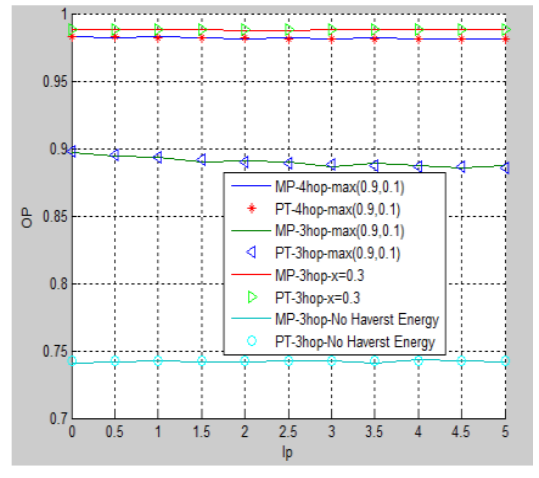
Fig. 10. OP versus b: K=3, K=4, ( x PU , y PU )=